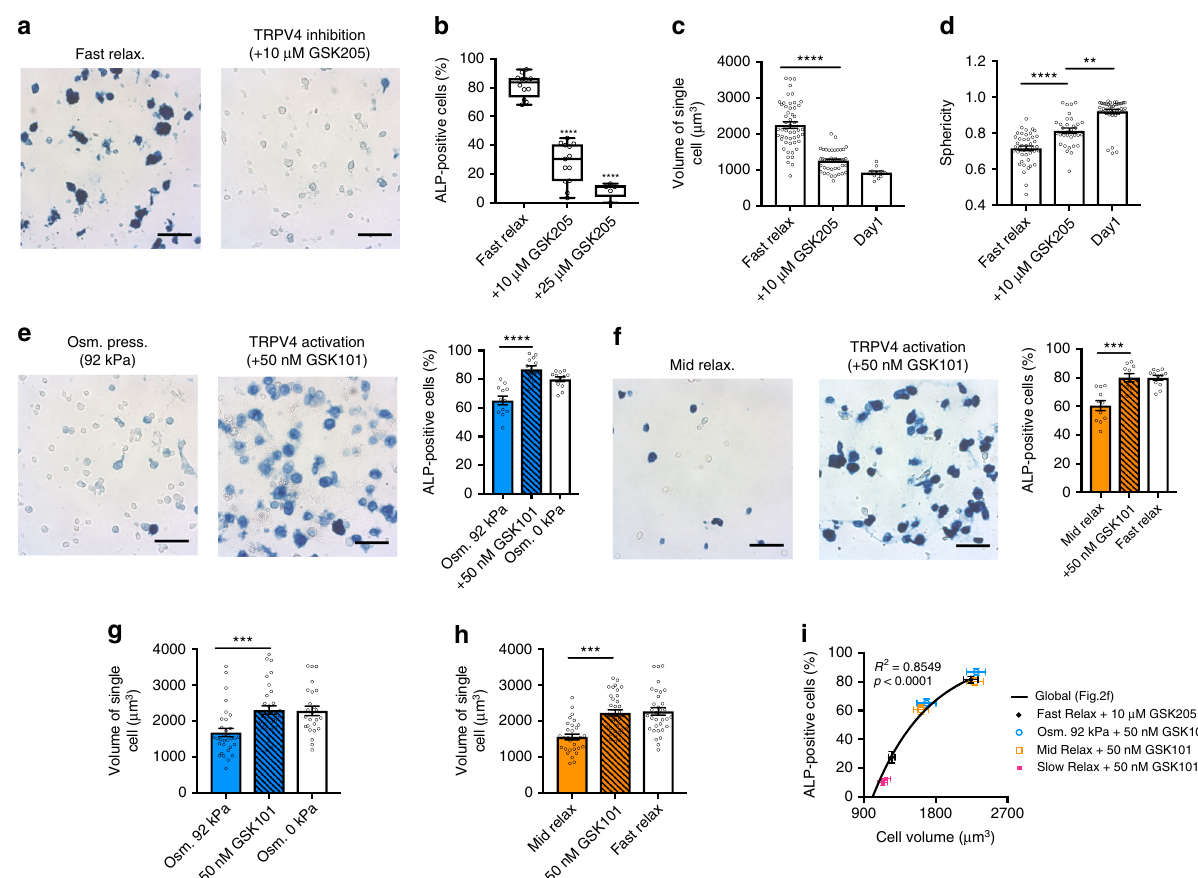
Fig. 4 Feedback between TRPV4 activation and volume expansion regulates osteogenesis. a Representative images with ALP staining of MSCs cultured in fast-relaxing hydrogel with or without treatment of TRPV4 antagonist for 7 days. b Quanti fi cation of the percentage of cells positively stained for ALP under indicated conditions ( n ≥ 10 images from three biological replications per each condition, **** p <0.0001 compared with control by one-way ANOVA test). The box plots show 25/50/75th percentiles and whiskers show minimum/maximum. c , d Quanti fi cation of cell volumes ( c ) and sphericity ( d ) of MSCs cultured in fast-relaxing gels under indicated conditions for 7 days ( n ≥ 35 single cells from three biological replications per each condition, **** p <0.0001, and ** p <0.01 by one-way ANOVA test). e , f Representative images of ALP staining and quanti fi cations of the percentage of cells positively stained for ALP of MSCs cultured in fast-relaxing hydrogel under osmotic pressure of 92 kPa ( e ) and in mid relaxing hydrogel under osmotic pressure of 0 kPa ( f ) with or without treatment of TRPV4 agonist for 7 days ( n ≥ 10 images from three biological replications per each condition, **** p <0.0001 by student t test). g , h Quanti fi cation of volume of single cells cultured in fast-relaxing hydrogel under osmotic pressure of 92 kPa ( g ) and in mid relaxing hydrogel under osmotic pressure of 0 kPa ( h ) with or without treatment of TRPV4 agonist for 7 days ( n ≥ 30 single cells from three biological replications per each condition, *** p <0.001 by Student's t test). i Scatter plot of cell volume with the percentage of cells positively stained for ALP, when MSCs were cultured in indicated conditions with treatment of TRPV4 antagonist or agonist. The black line obtained by linear regression of data in Fig. 2f is shown. Scale bar, 25 µ m. All data are shown as mean ±